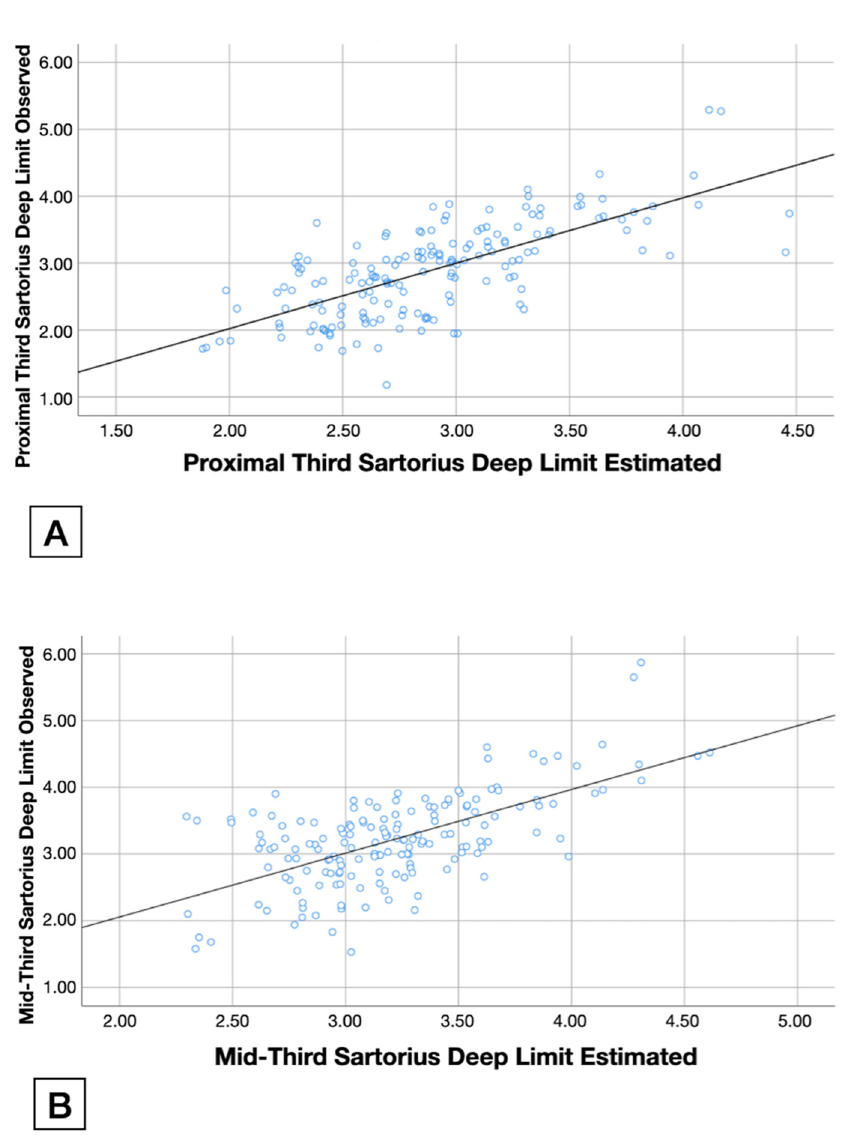
Figure 3. Real ( Y -axis) and estimated ( X -axis) values of sartorius deep limit in cm at the proximal third ( A ) and mid-third ( B ). Blue points represent each participant and black lines represent the tendency.